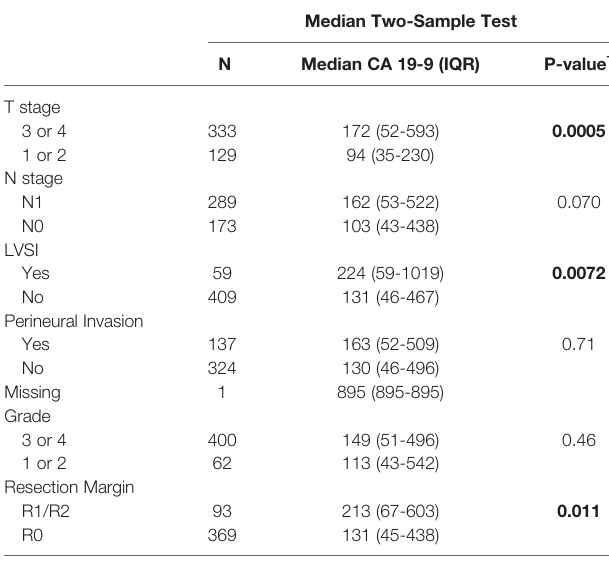
TABLE 2 | The association of CA 19-9 and adverse pathologic features among patients with normal and elevated CA 19-9 is demonstrated. Median Two-Sample